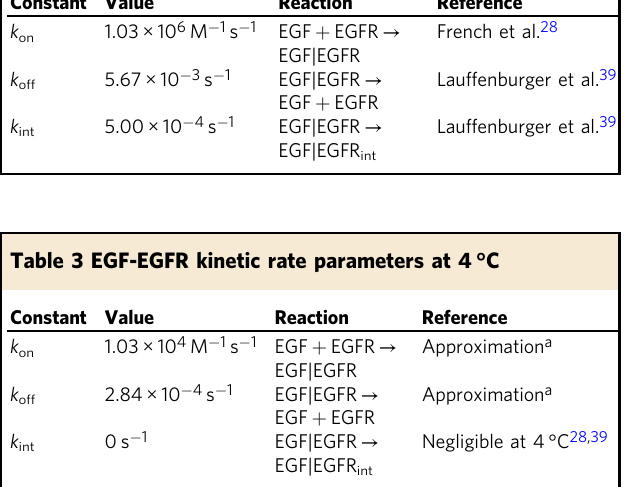
Table 2 EGF-EGFR kinetic rate parameters at 37 °C Constant Value